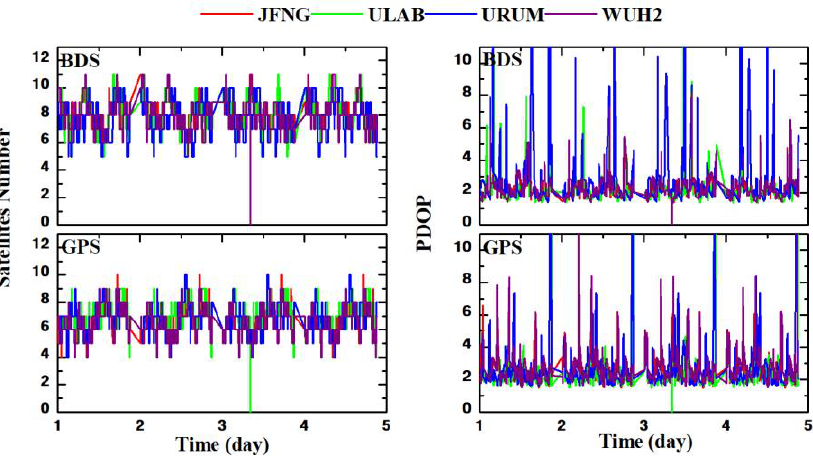
Figure 2. Number of visible satellites and PDOP values of the four MEGX stations.